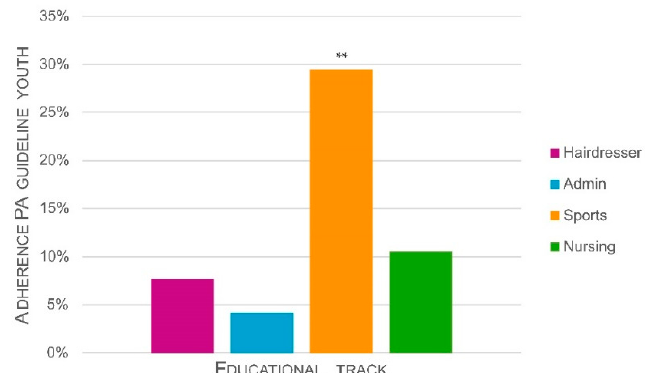
Figure 5. Differences between educational tracks in adherence to physical activity (PA) guidelines for youths. Significant Bonferroni corrected post-hoc tests are indicated with asterisks (** = p < 0.01).